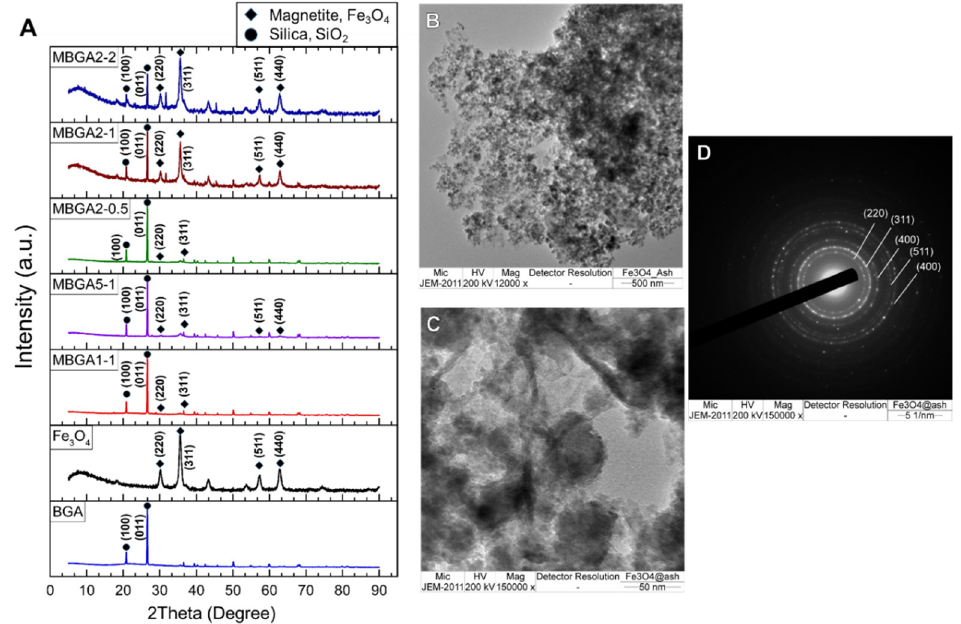
Figure 2. ( A ) XRD patterns for all samples ( B , C ) TEM image of MBGA2-1 at 12,000 × and 150,000 × , respectively ( D ) SAED pattern showing diffraction rings corresponding to Fe 3 O 4 .